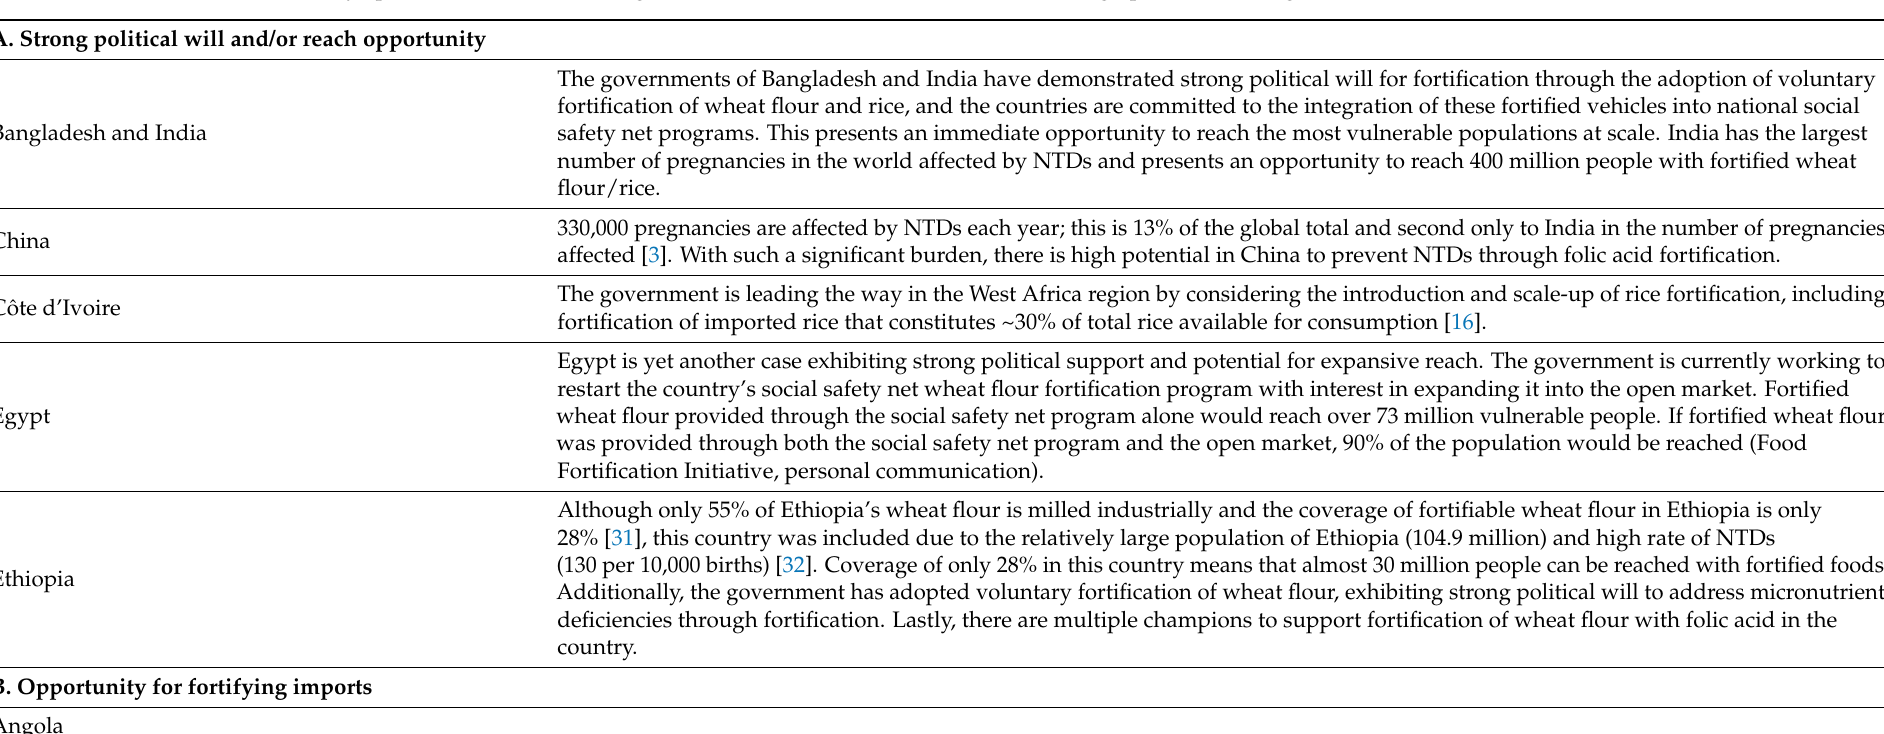
Table 2. Country-specific reasons for selecting 18 low- and middle-income countries with high potential for large-scale fortification of wheat